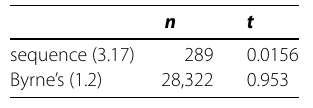
Table 1 (cid:2) = 10 –5 , P = 5, M = 3, N = 2